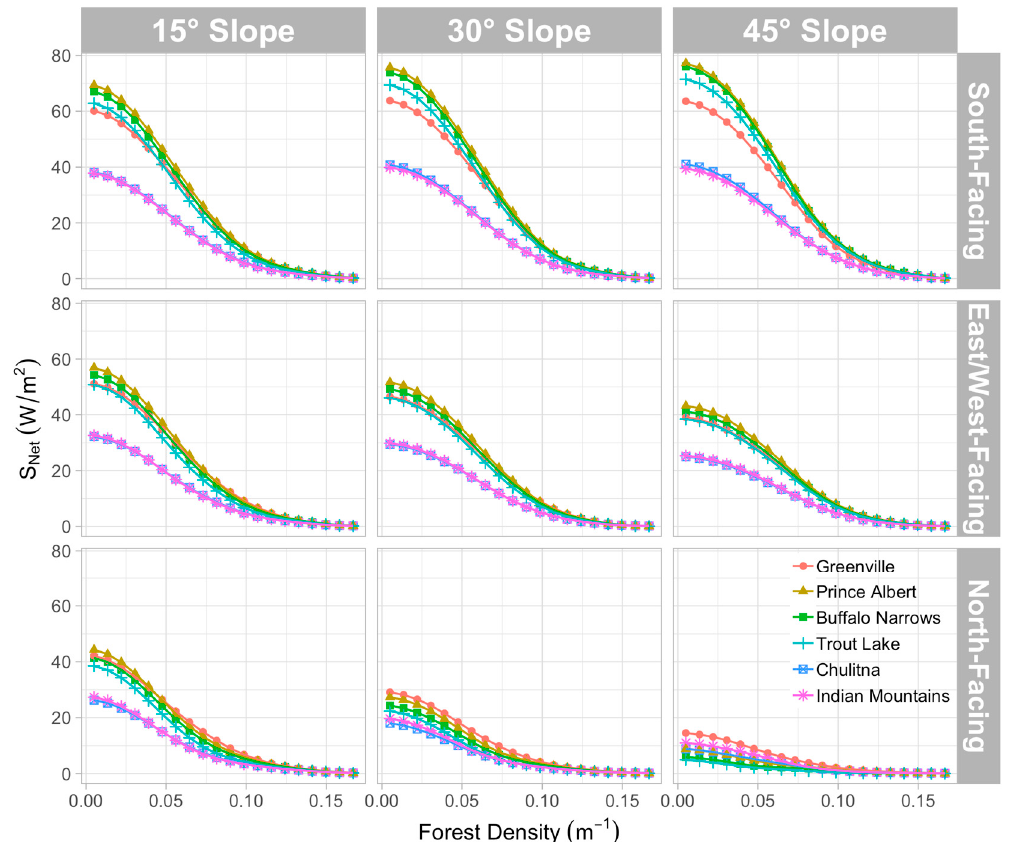
Figure 4. Variations of net shortwave radiation with vegetation density at different sites for different slope angles and aspects of the forested hillslope under interspersed cloudy sky conditions. Legend lists the sites in increasing order of latitude from top to bottom.